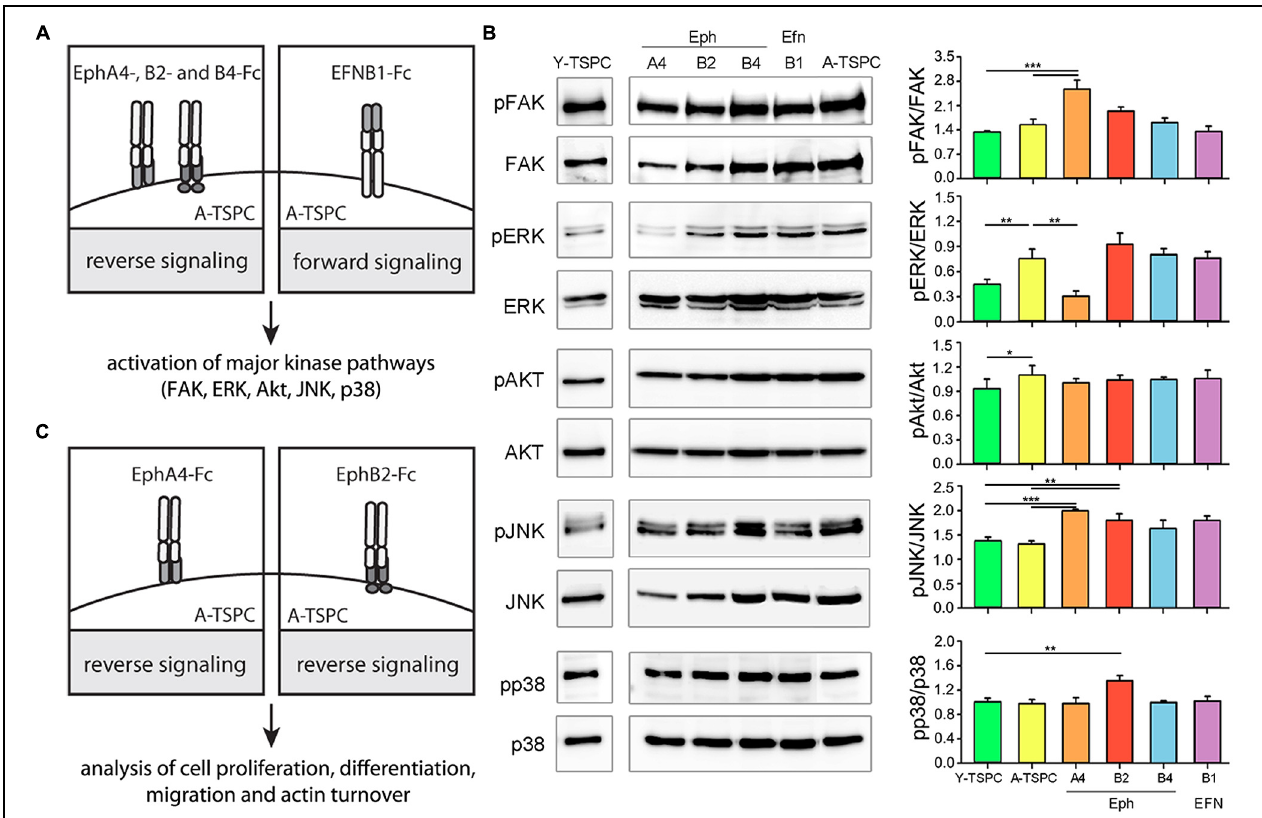
FIGURE 2 | Experimental design and western blot analysis of key cellular kinases in TSPC. (A) Schematic presentation of A-TSPC stimulation with clustered ephrins. (B) Western blot analysis of phosphorylated and total FAK, ERK, Akt, JNK, and p38 kinases in Y-TSPC and EphA4-Fc, EphB2-Fc, EphB4-Fc, EFNB1-Fc, and control-Fc A-TSPC. Data consists of two independent repeats with all three Y-and A-TSPC donors ( n = 6, ∗ p < 0.05; ∗∗ p < 0.01; ∗∗∗ p < 0.001). (C) Experimental study design.